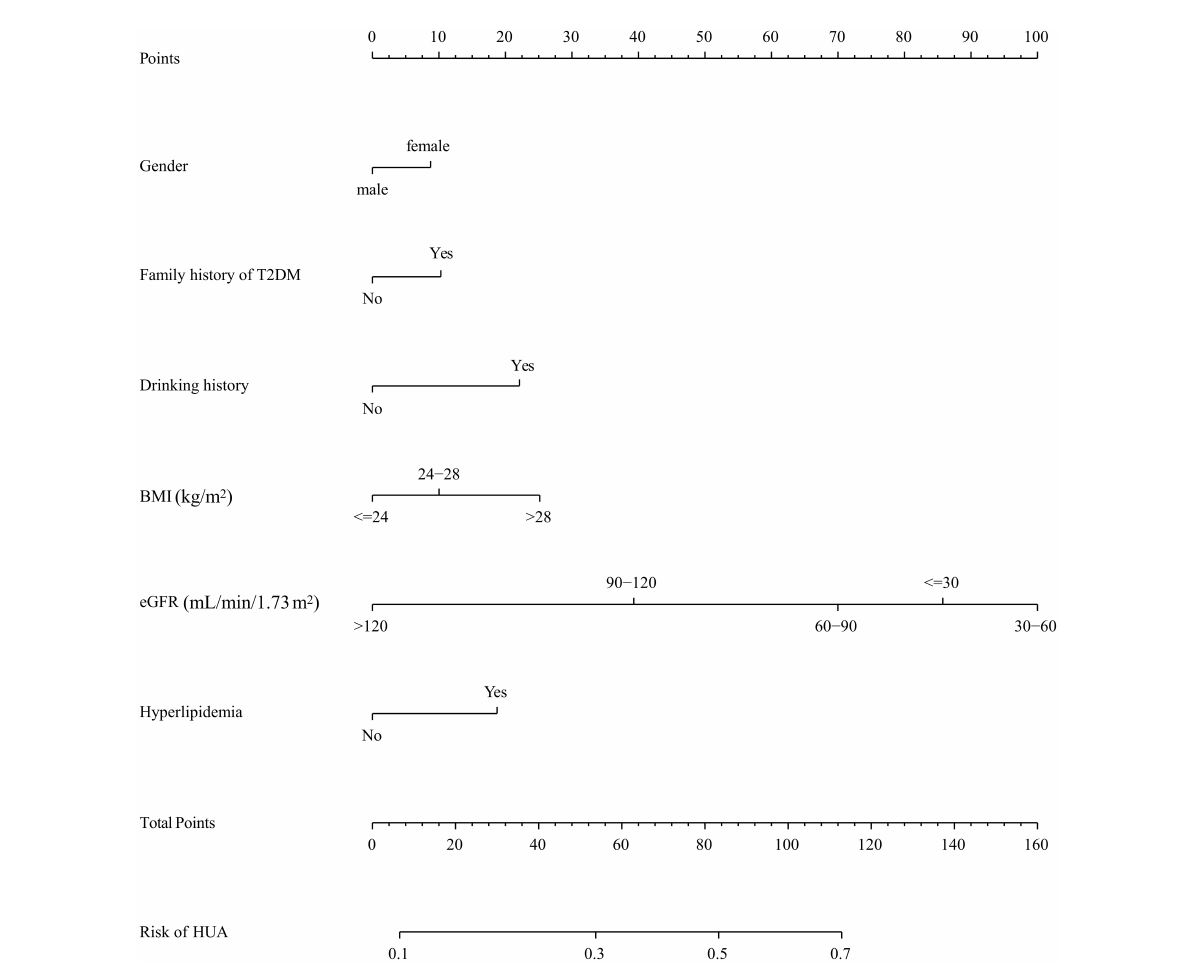
FIGURE3 A nomogram for predicting the probability of developing HUA in DKD population. The nomogram is used by scoring each variable on its corresponding score scale. The scores for all variables are then summed to obtain the total score, and a vertical line is drawn from the total point row to indicate the estimated probability of the development of HUA in DKD population. DKD, diabetic kidney disease; BMI, body mass index; eGFR, estimated glomerular filtration